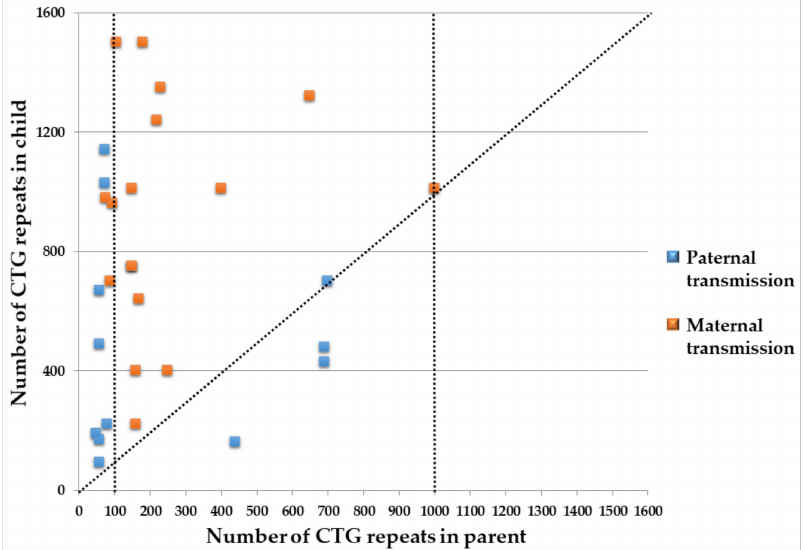
Figure 1. Intergenerational influence of gender between the transmitting parent and the affected child. ( a ) The CTG repeat size of the DMPK in the affected child was significantly greater when the DMPK repeats were transmitted from a female parent to a female child (DM1-FF) (median, 1309 repeats; range, 400–2083) than when they were transmitted from a male parent to a male child (DM1-MM) (650; 160–1030; p = 0.038 and 0.048 using the Tukey HSD and the Bonferroni test) and from a male parent to a female child (DM1-MF) (480; 94–1140; p = 0.003). ( b ) The difference in the CTG repeat size of the DMPK between the transmitting parent and the affected child was also higher in DM1-FF than in DM1-MM and in DM1-MF, but this result was not statistically significant.